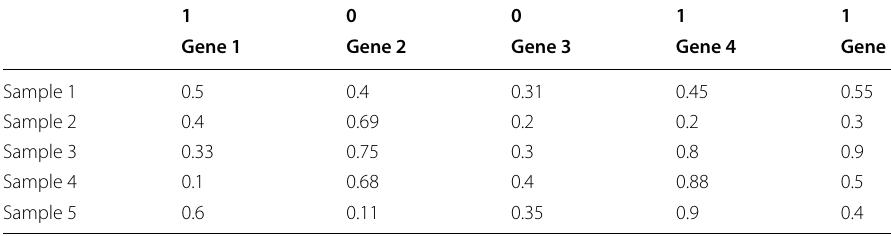
Table 4 Example of gene expression data with particle position